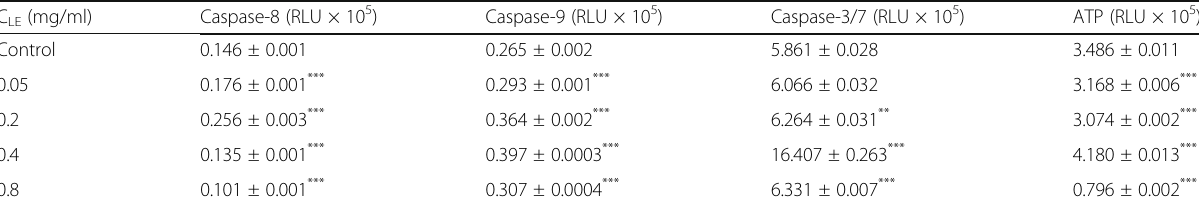
(Values expressed as mean ± SD, ** p < 0.001, *** p < 0.0001 compared to the